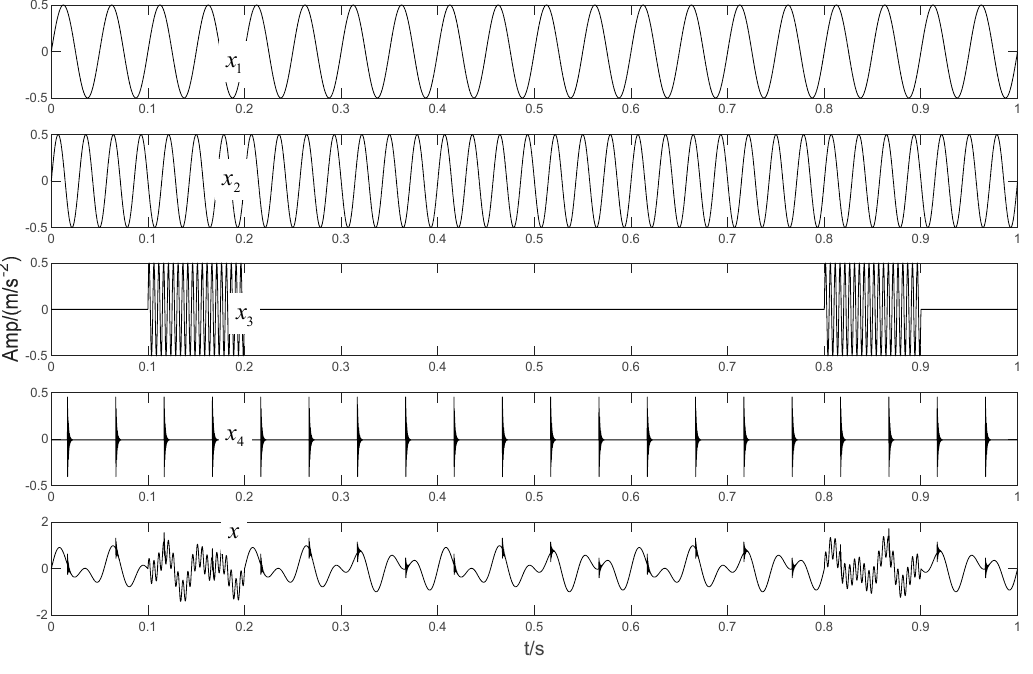
Figure 3. The simulated signal.